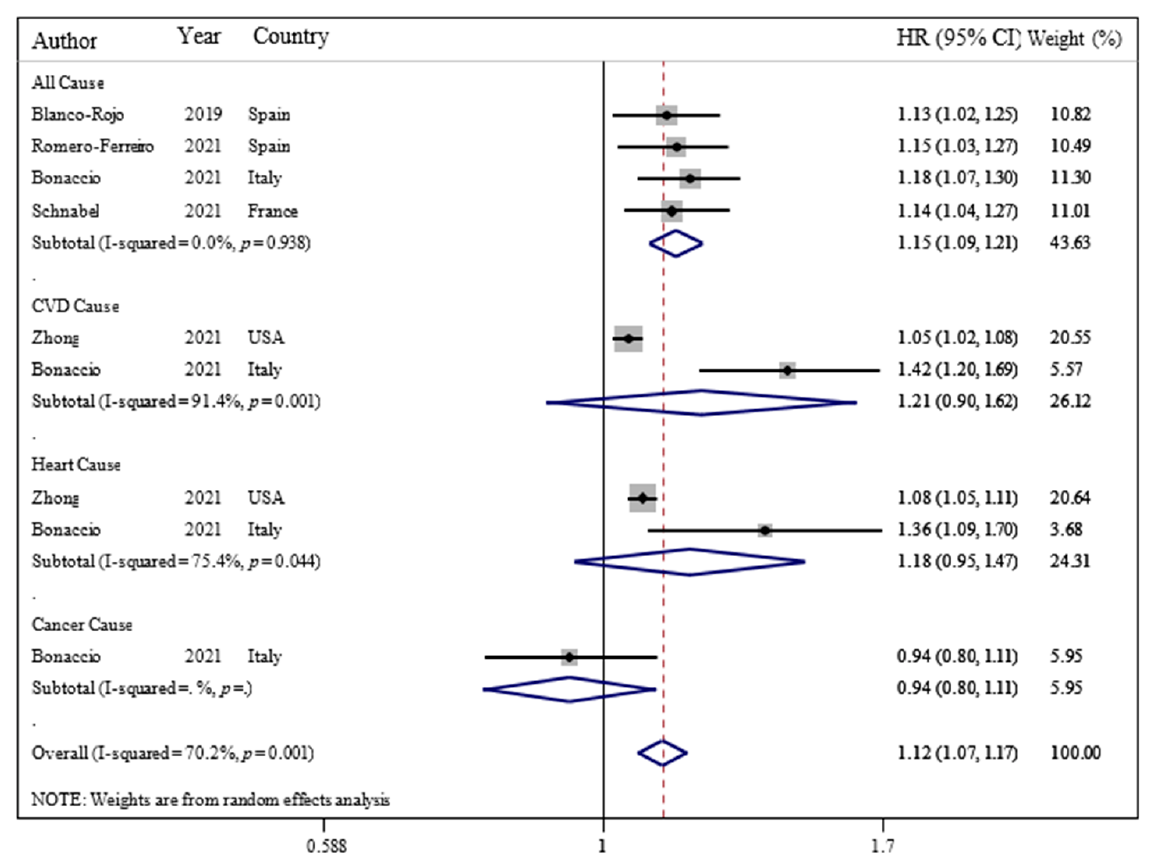
Figure 3. Forest plots showing the linear dose–response meta-analysis of mortality risk for 10% change in ultra-processed food consumption in daily intake. The study-specific HR and 95 % CI are represented by black squares and horizontal lines, respectively; the area of the grey square is proportional to the specific-study weight to the overall meta-analysis. The center of the open diamond